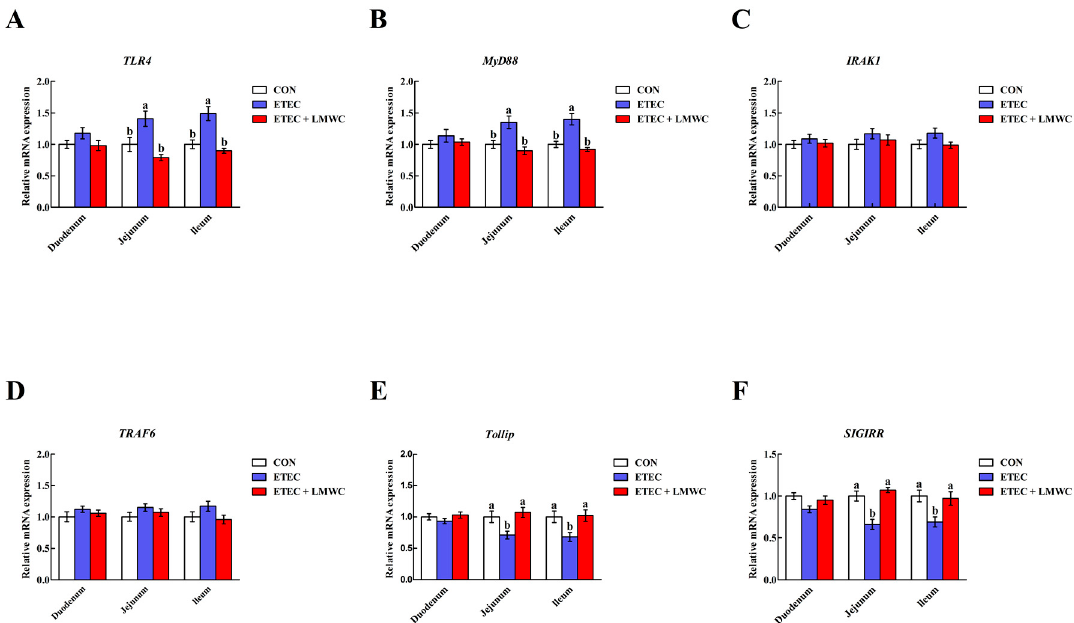
Figure 6. Effects of low-molecular-weight chitosan on the mRNA levels of TLR4 ( A ), MyD88 ( B ), IRAK1 ( C ), TRAF6 ( D ), Tollip ( E ) and SIGIRR ( F ) in the small intestine of weaned pigs challenged with enterotoxigenic Escherichia coli . ( A ) TLR4 , Toll-like receptor 4. ( B ) MyD88 , myeloid differentiation factor 88. ( C ) IRAK1 , interleukin-1 receptor-associated kinase 1. ( D ) TRAF6 , tumour necrosis factor receptor-associated factor 6. ( E ) Tollip , Toll-interacting protein. ( F ) SIGIRR , single immunoglobulin interleukin-1 receptor-related molecule. a, b Means with different letters on vertical bars indicate significant differences ( P < 0.05). Values are means ( n = 8 pigs/treatment), with standard errors represented by vertical bars. CON: non-infected control (pigs that received a basal diet infused with sterilised Luria–Bertani culture); ETEC: ETEC-infected control (pigs that received the basal diet infused with enterotoxigenic Escherichia coli ); ETEC + LMWC: pigs that received the basal diet supplemented with 100 mg/kg low-molecular-weight chitosan and infused with enterotoxigenic Escherichia coli .